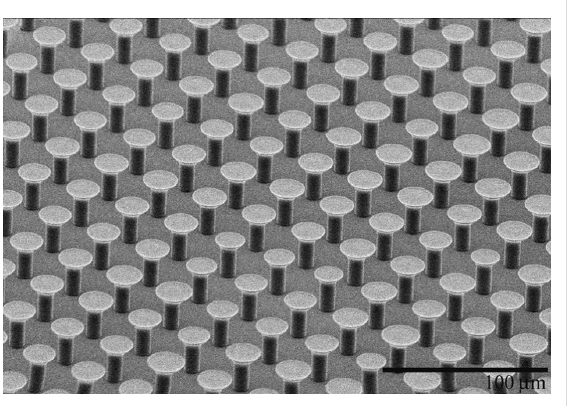
Figure 1: Scanning electron microscope image of polyurethane mush- room-like fibers with 4 µm stalk radius, 8 µm tip radius, and 20 µm